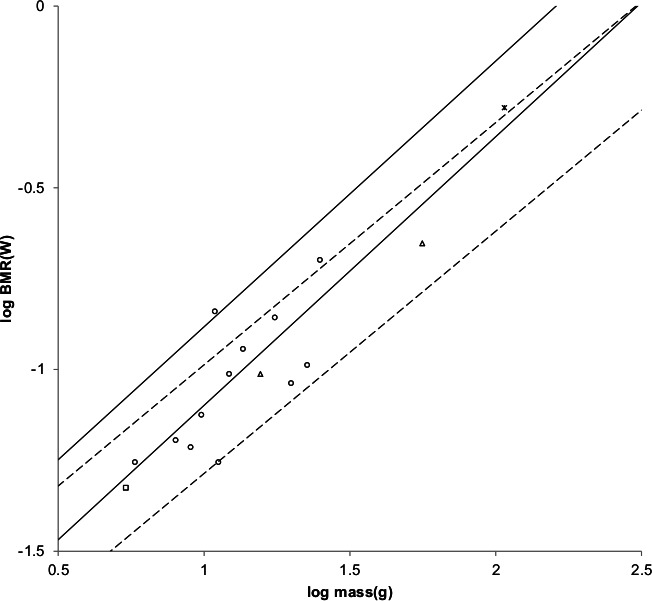
Log BMR as a function of log body mass for intermediate bats.The solid and dashed lines are the MMLE sturdiness factor boundaries. The upper boundaries were generated with a sturdiness factor s = (3)0.5. The lower boundaries were generated with s = (3)−0.5. The steeper sloping solid boundary lines are for heavy bat Strouhal dynamic similarity. The shallower sloping dashed boundary lines are for light bat geometric similarity. Data was available for only four of the eight families comprising the intermediate bats. \documentclass[12pt]{minimal}
\usepackage{amsmath}
\usepackage{wasysym}
\usepackage{amsfonts}
\usepackage{amssymb}
\usepackage{amsbsy}
\usepackage{upgreek}
\usepackage{mathrsfs}
\setlength{\oddsidemargin}{-69pt}
\begin{document}
}{}${R}_{M}^{2}=0.9678$\end{document}RM2=0.9678 for intermediate bats with respect to the Strouhal boundaries. \documentclass[12pt]{minimal}
\usepackage{amsmath}
\usepackage{wasysym}
\usepackage{amsfonts}
\usepackage{amssymb}
\usepackage{amsbsy}
\usepackage{upgreek}
\usepackage{mathrsfs}
\setlength{\oddsidemargin}{-69pt}
\begin{document}
}{}${R}_{M}^{2}=0.9893$\end{document}RM2=0.9893 for intermediate bats with respect to the geometric boundaries. \documentclass[12pt]{minimal}
\usepackage{amsmath}
\usepackage{wasysym}
\usepackage{amsfonts}
\usepackage{amssymb}
\usepackage{amsbsy}
\usepackage{upgreek}
\usepackage{mathrsfs}
\setlength{\oddsidemargin}{-69pt}
\begin{document}
}{}${R}_{M}^{2}=0.9998$\end{document}RM2=0.9998 for intermediate bats with respect to both sets of boundaries. The data are species-averaged. Megadermatidae are marked with crossed Xes. Molossidae are marked with open triangles. Vesperstilionidae are marked with open circles. Natalidae are marked with open squares.